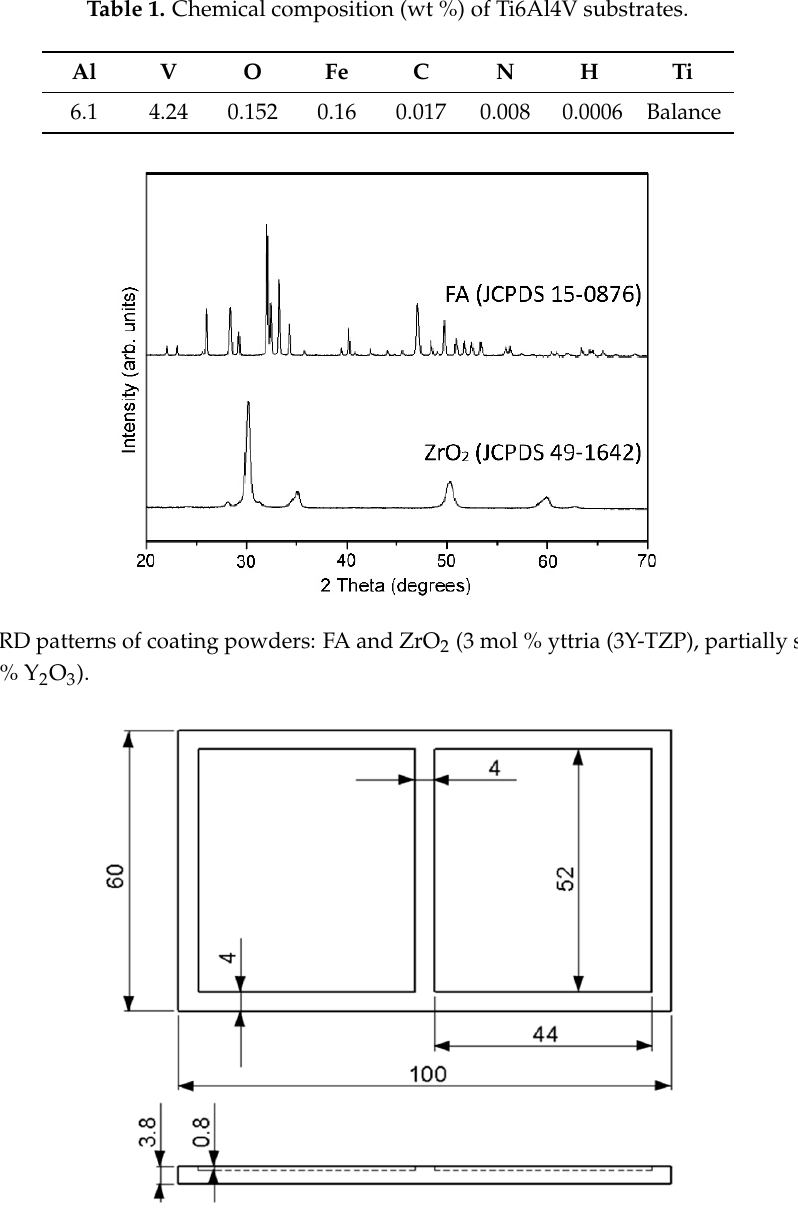
Figure 2. Schematic illustration of Ti6Al4V substrate (unit: mm).